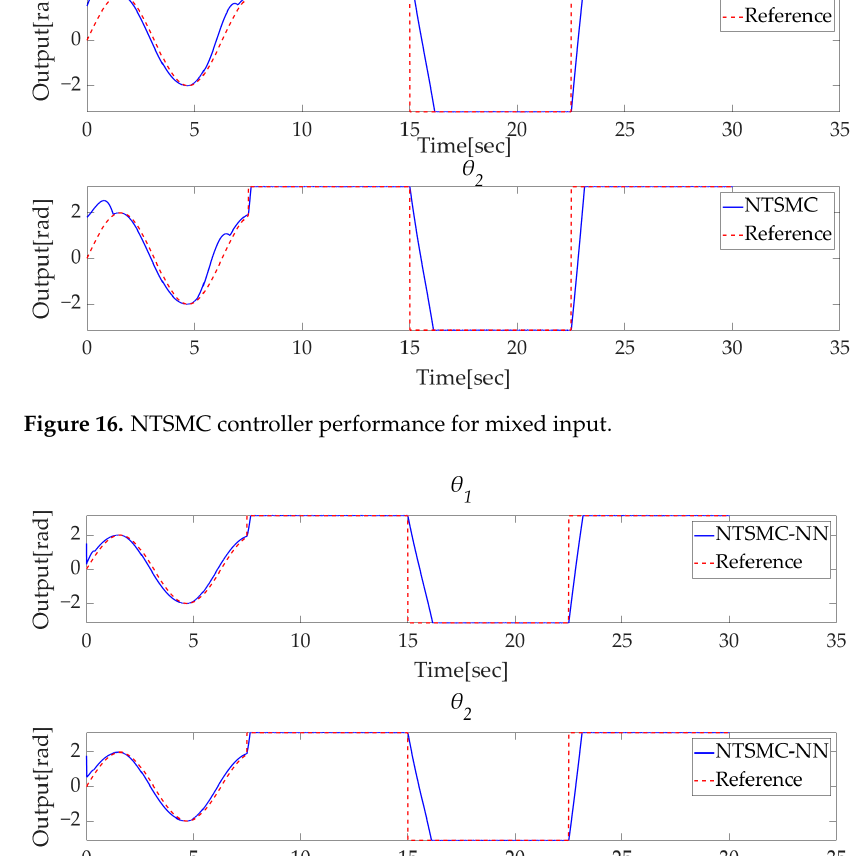
Figure 18. RT-NTSMC-NN controller performance for mixed input.